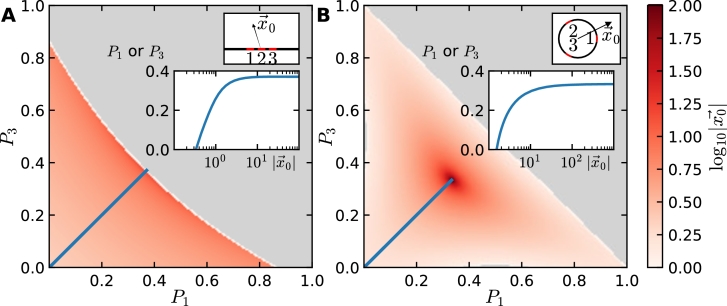
Distance to the source as a function of the flux. (A) Three receptors arranged on the boundary of the half-plane, and (B) three receptors equally spaced on the circumference of a disk. The color shading indicates the logarithmically scaled distance to the source as a function of the two independent fluxes P1 and P3. The grey area indicates invalid flux combinations due to the condition ∑iPi = 1. The top inset displays the arrangement of windows and the lower inset shows the relationship between the fluxes and the source distance along the blue line. Note that in both cases, the distance increases nonlinearly as a function of P1/3, hence the recovery of the source position is robust against flux noise only at short distances. (For interpretation of the references to color in this figure legend, the reader is referred to the web version of this article.)